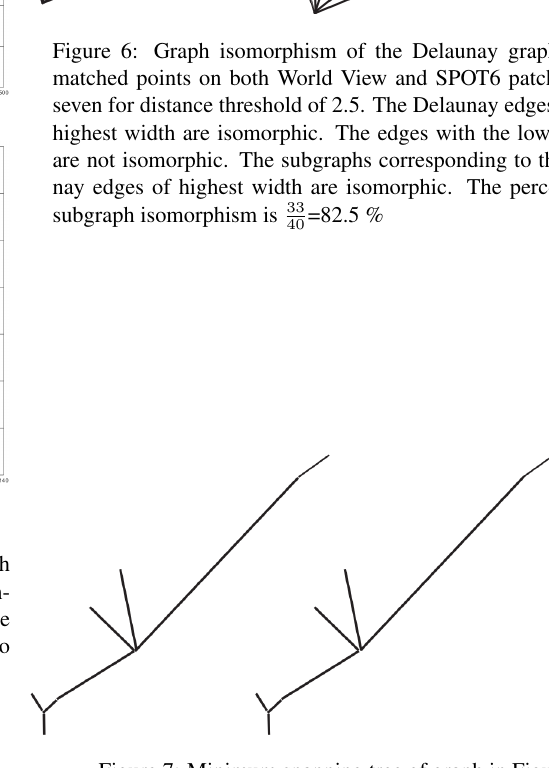
Figure 7: Minimum spanning tree of graph in Figure 5